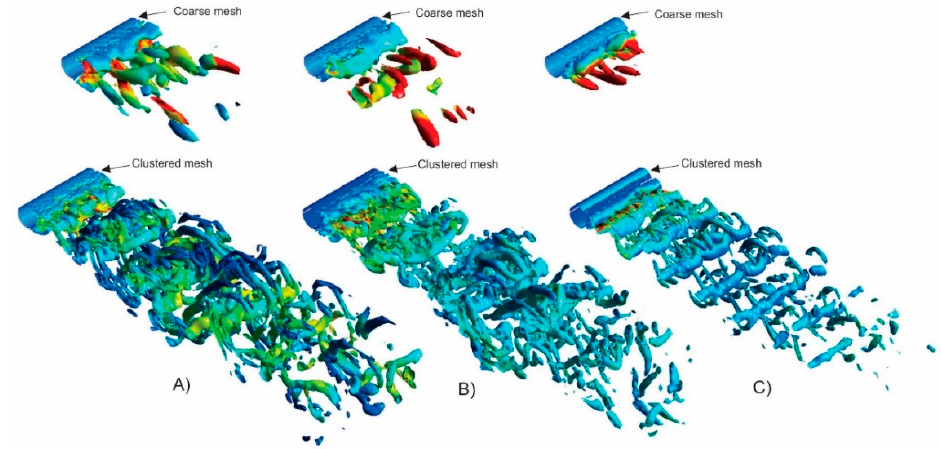
Figure 14. Normalized Reynolds stress distribution v (cid:48) v (cid:48) /U 2 in the wake region showing effect of mesh density for all three models.